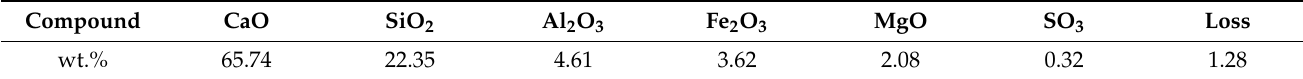
Table 1. The chemical composition of P.O 52.5R cement